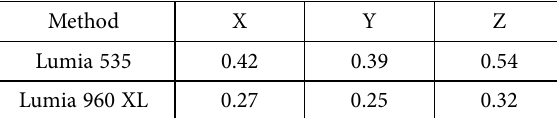
Table 4. Values of RMSEs for object space coordinates of deflection points (in